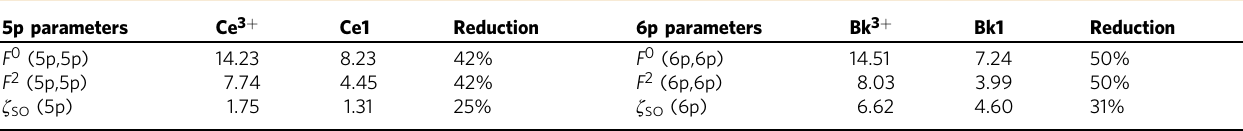
Fig. 4 CASSCF natural orbitals and ligand- fi eld DFT parameters. Natural orbitals derived from state-speci fi c scalar-relativistic CAS(1,7) and CAS(8,7) for Ce1 and Bk1 . a For both complexes, there is an f -orbital similar to the f ±3 orbital that shows a preferential orbital interaction between the metal center, terpy*, and the water molecule. This orbital is crucial to de fi ne the plane of covalency. b Orbital mixing between the 5 p /6 p orbitals with 2 p -ligand orbitals showing the participation of the core in chemical bonding. Table 3 Ligand- fi eld DFT